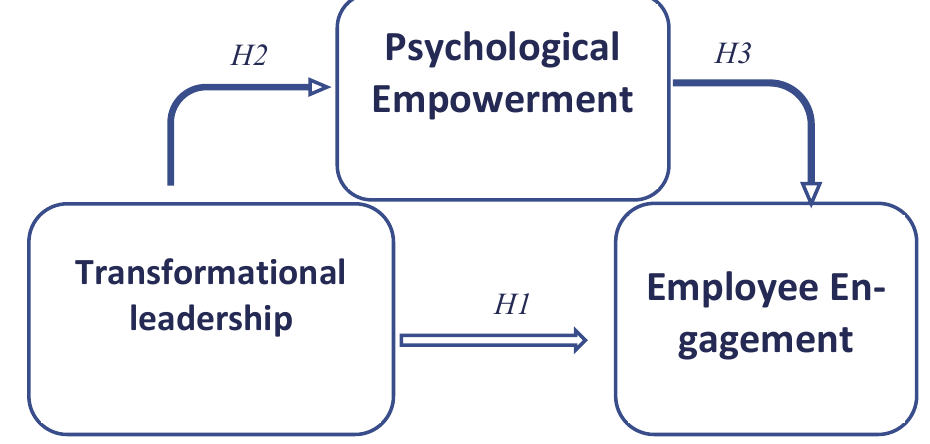
Fig.1. Conceptual frame